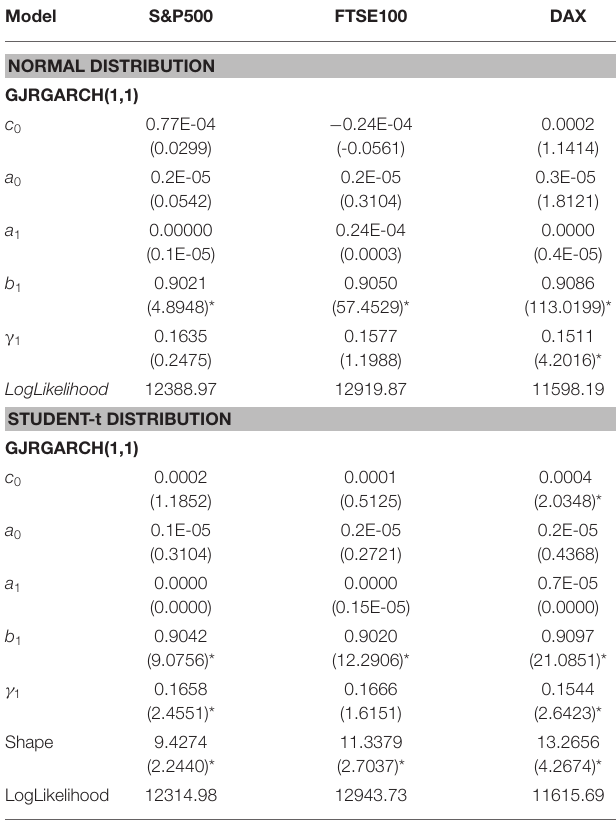
TABLE 7 | Parameter estimates GJRGARCH model for three equity indices using the entire data set and assuming two alternative distributions for the residuals, t-statistics are presented in